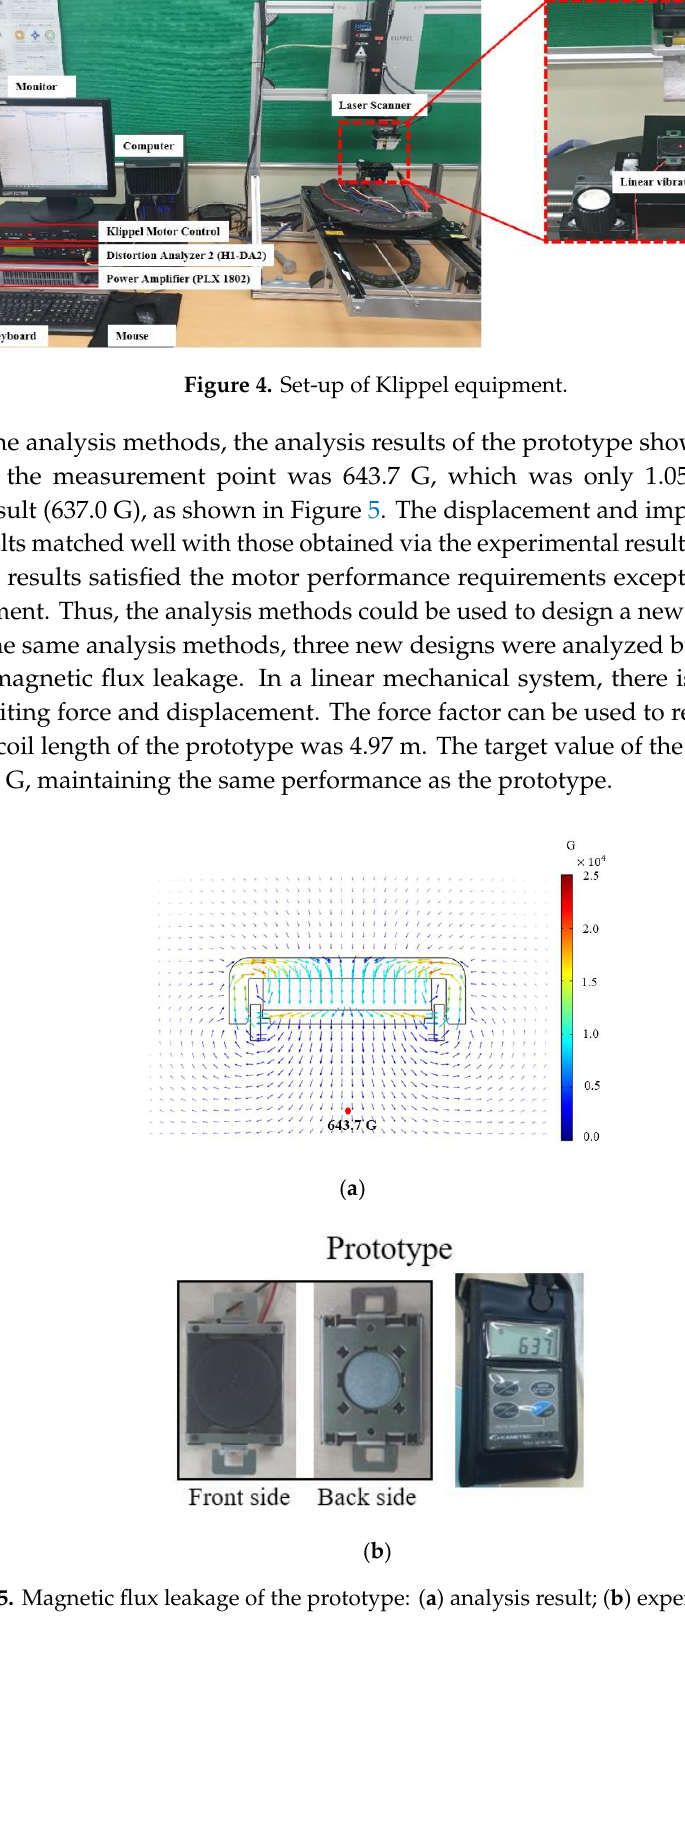
Figure 5. Magnetic flux leakage of the prototype: ( a ) analysis result; ( b ) experiment results.